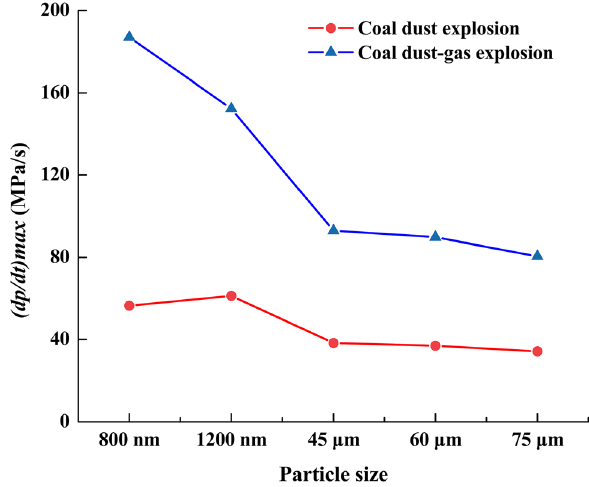
Fig. 13 Maximum pressures of various methane–coal